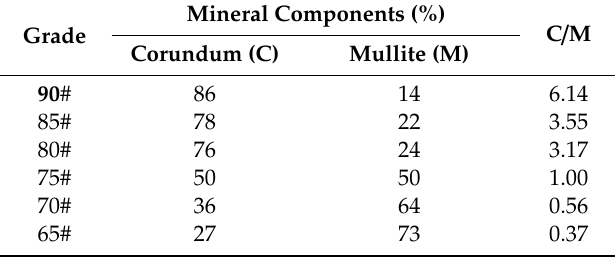
Table 6. Main mineral components of calcined bauxite.